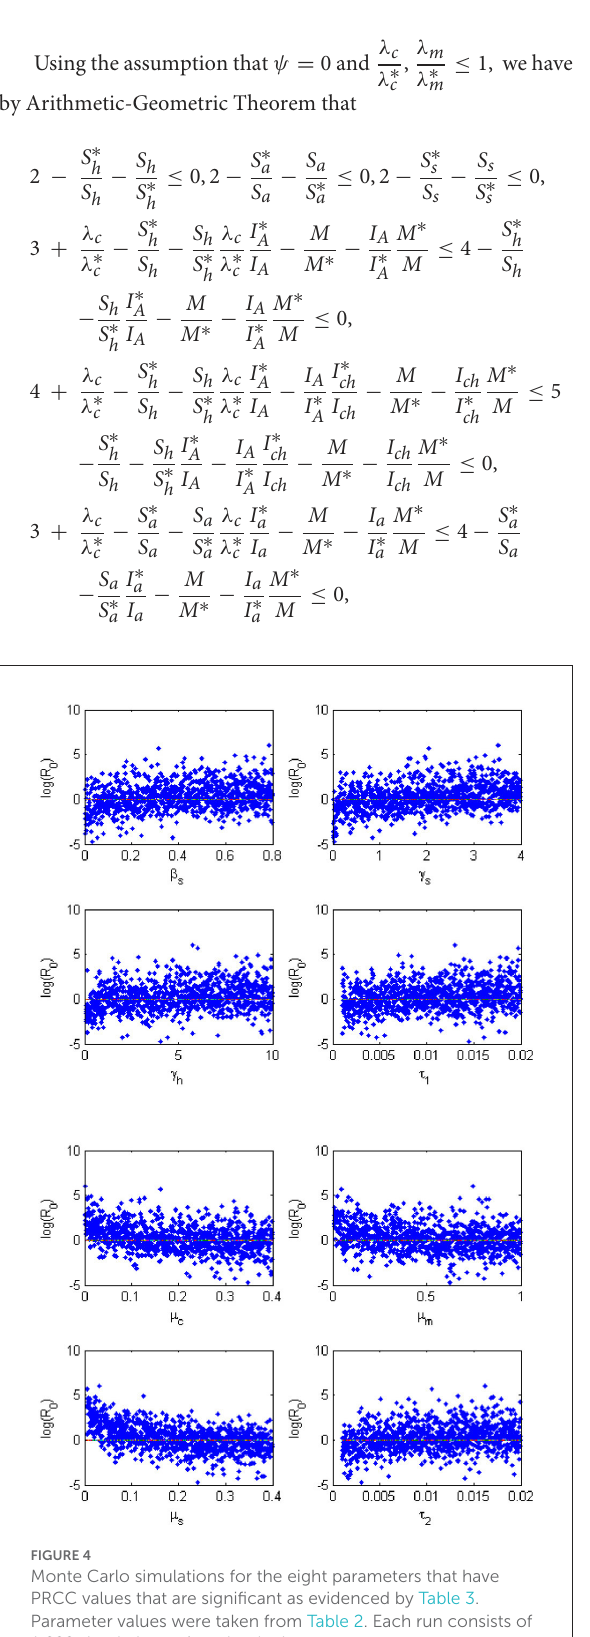
FIGURE4 Monte Carlo simulations for the eight parameters that have PRCC values that are significant as evidenced by Table 3. Parameter values were taken from Table 2. Each run consists of 1,000 simulations of randomly drawn parameters.